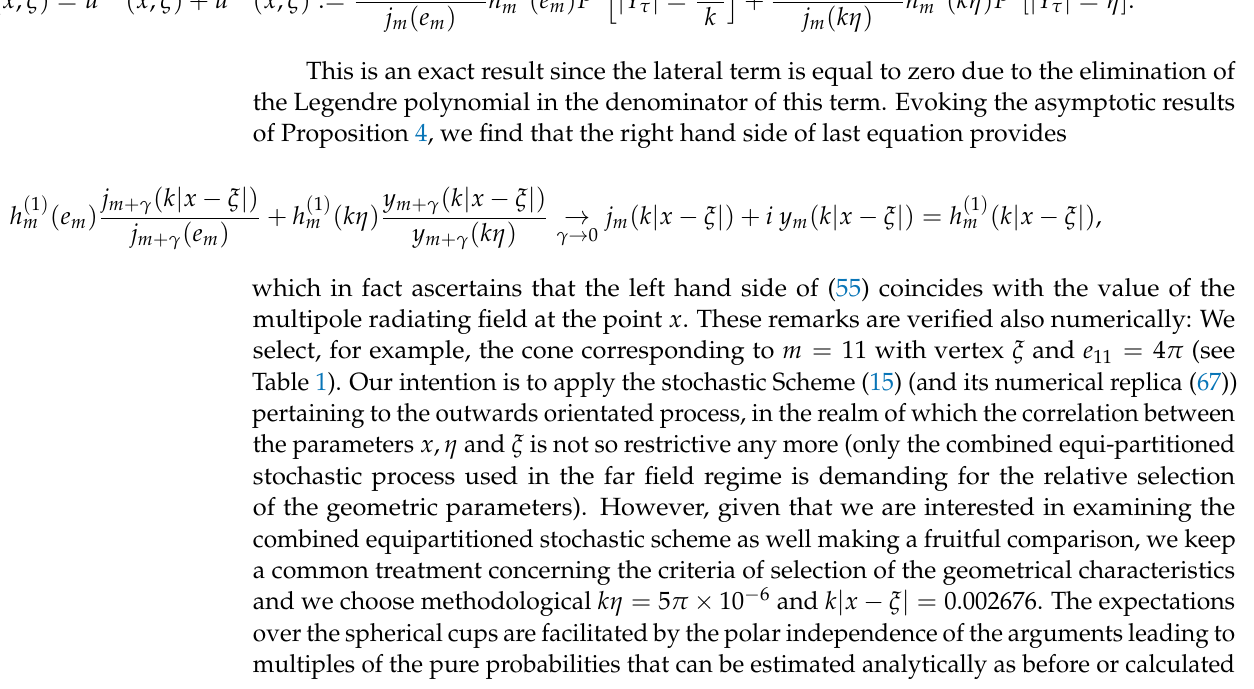
Figure 10. The reconstruction of the ellipsoidal surface x 2 ˆ k = − 1 √ ( 1,1,1 ) and wave number k = 1 3